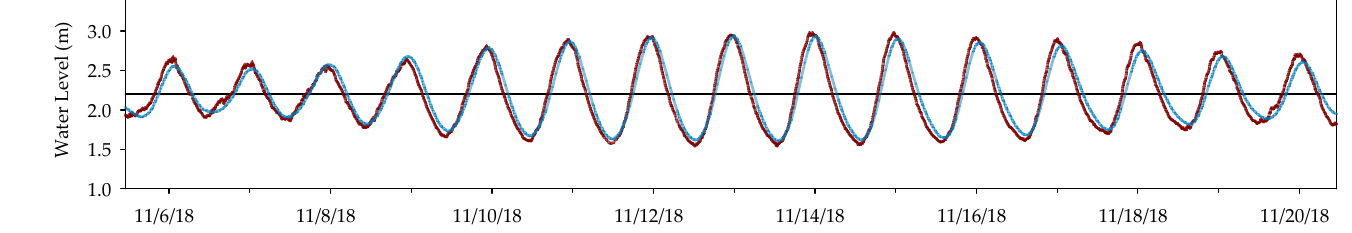
Figure 3. Validation of the simulation results at BH1 (red and blue line represent field measurement and simulation data, repectively).